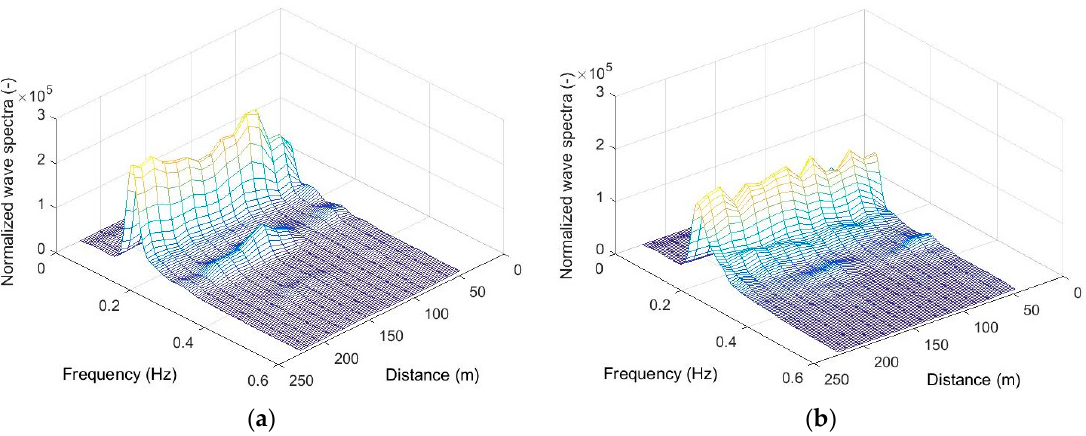
Figure 4. The evolution of wave spectra: ( a ) 28 September 2007, wave run 34; ( b ) 28 September 2007, wave run 42.